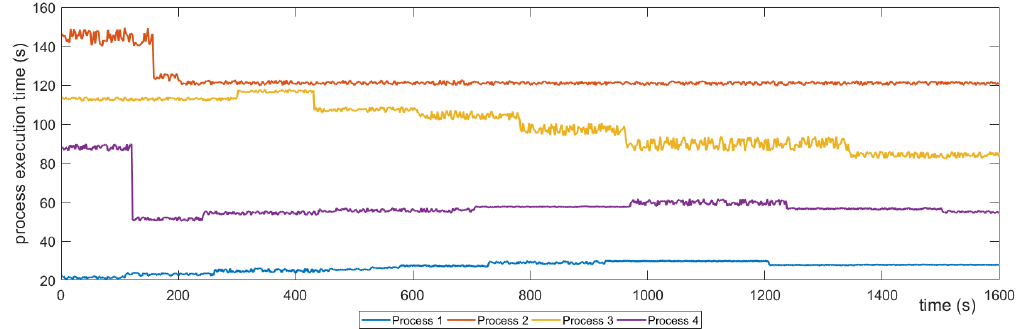
Figure 26. High priority processes.